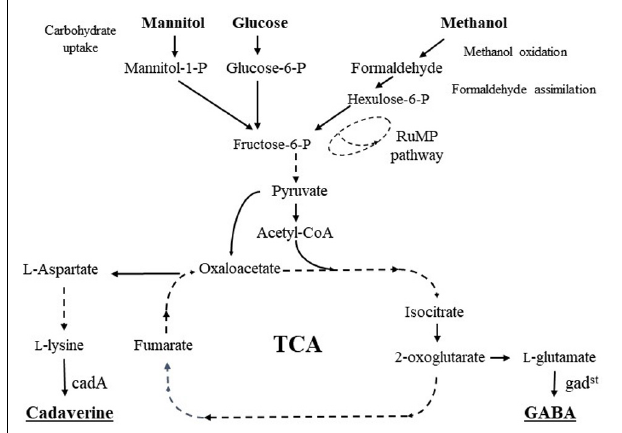
FIGURE 1 | Schematic presentation of carbon metabolism and pathways for L -lysine, cadaverine, L -glutamate, and GABA biosynthesis in B. methanolicus (adapted from Müller et al., 2015). Broken lines indicate multiple reactions. Mannitol-1-P, mannitol-1-phosphate; Glucose 6-P, Glucose-6-phosphate; Fructose-6-P, fructose-6-phosphate, Hexulose-6-P, hexulose-6-phosphate; RuMP pathway, ribulose monophosphate